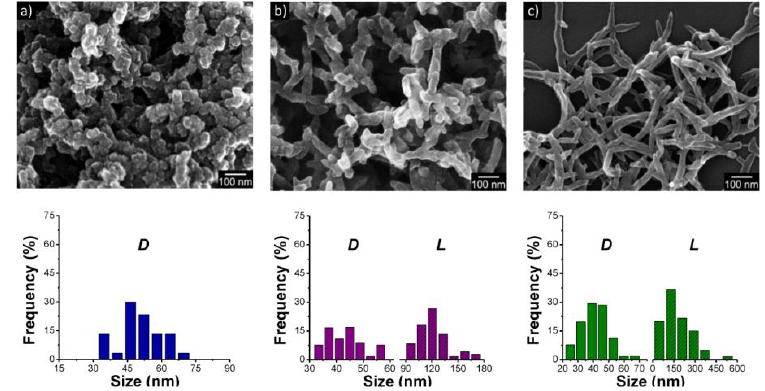
Figure 11. Field-emission scanning electron microscope images of PANI nanostructures with different aspect ratios synthesized under the same stirring conditions (200 rpm) and histograms showing their size distribution ( D , diameter; L , length): ( a ) nanospheres; ( b ) nanorods; and ( c ) nanofibers. With permission from [86]; Copyright 2012, American Chemical Society.